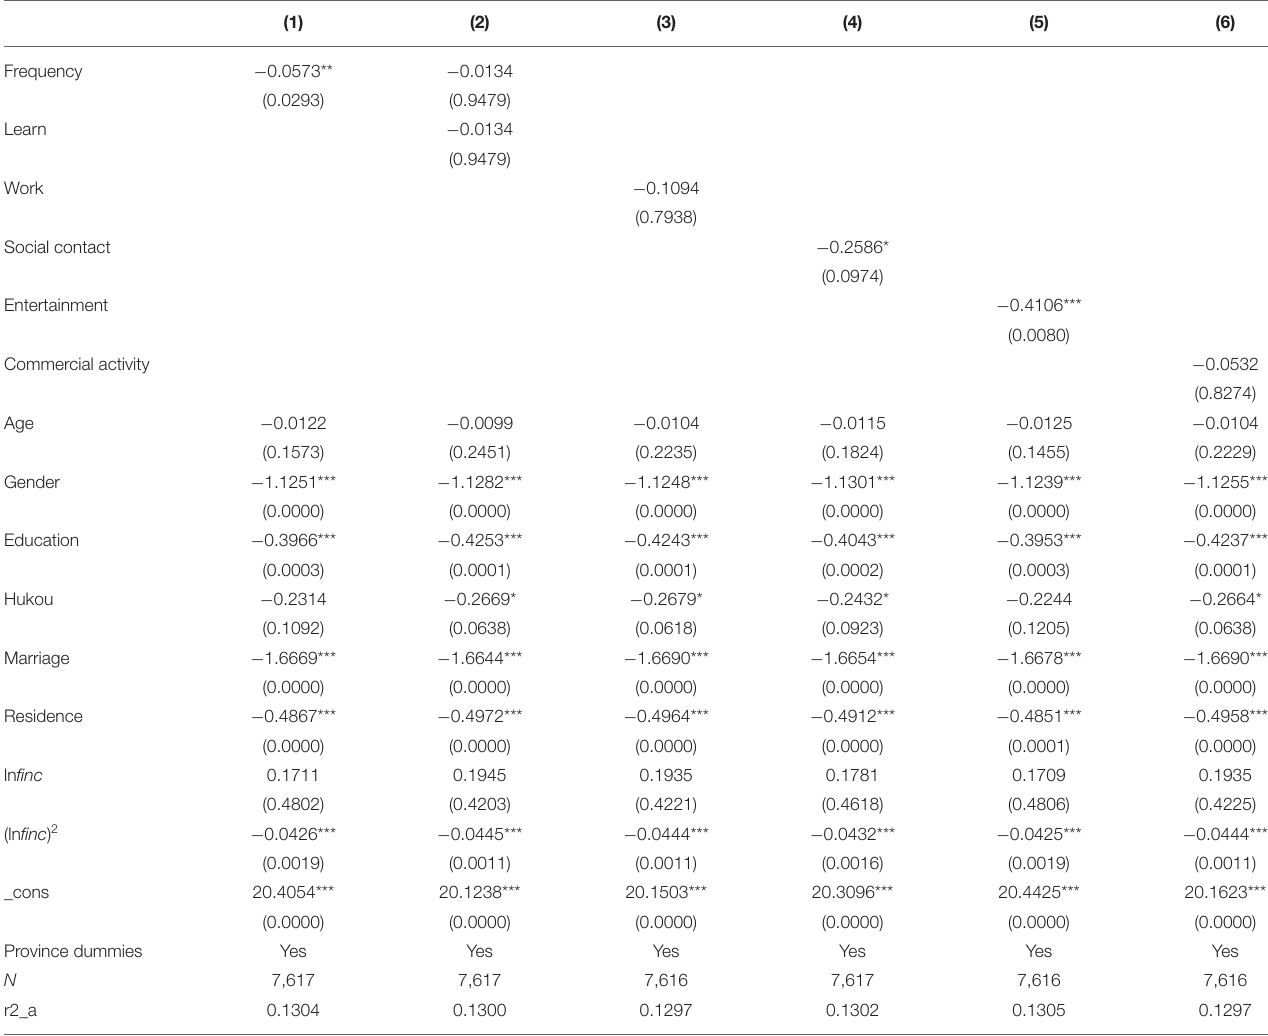
TABLE 3 | Impact of internet use frequency and the kind of internet usage using